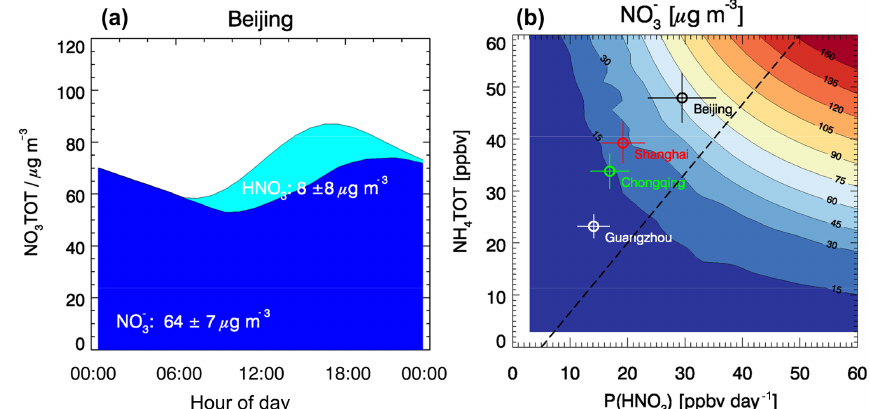
Figure 11. Modeled nitrate production from gas-phase oxidation. (a) The mean diurnal profile of the modeled total nitrate concentration and its gas–particle partitioning. (b) Functional dependence of particulate nitrate concentrations on the daily integrated nitrate production rate and total ammonium